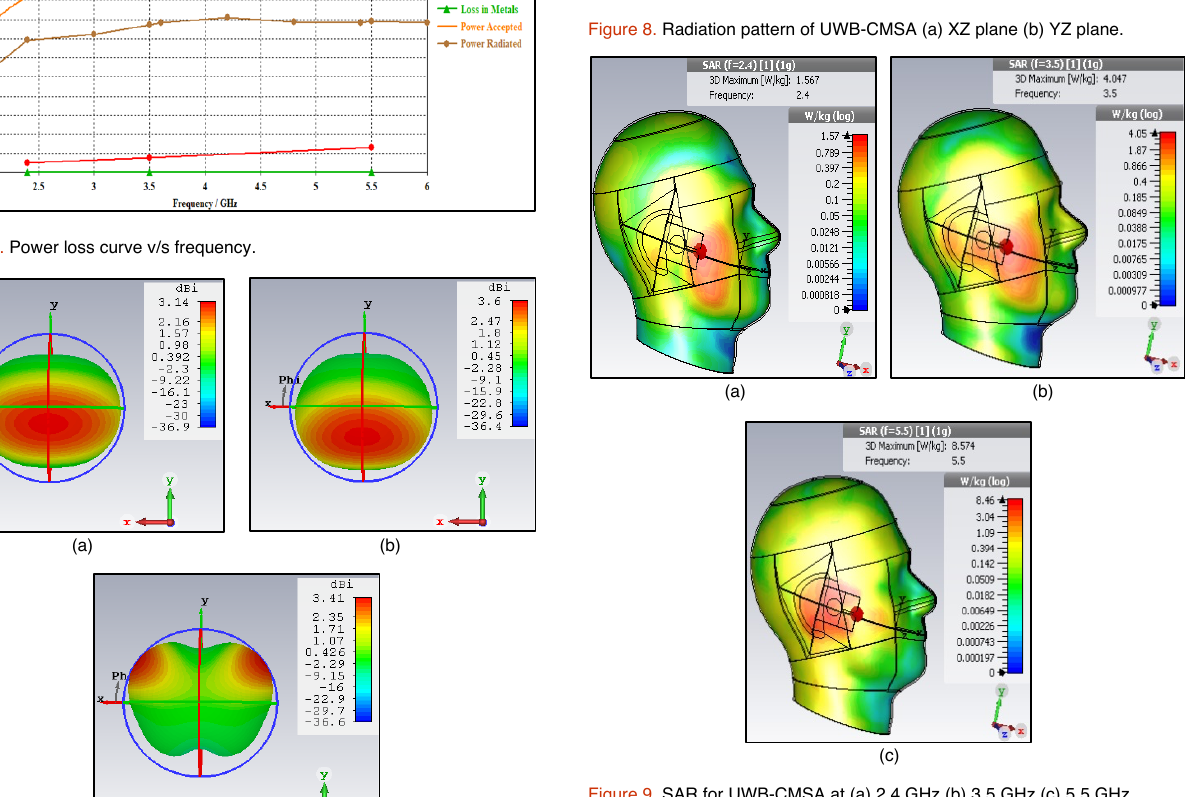
Figure 9. SAR for UWB-CMSA at (a) 2.4 GHz (b) 3.5 GHz (c) 5.5